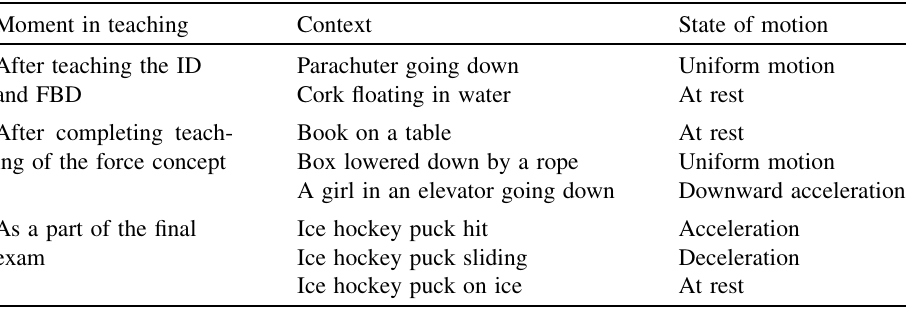
TABLE II. Post-test tasks on the interaction diagram and FBDs for the heavy and light ID